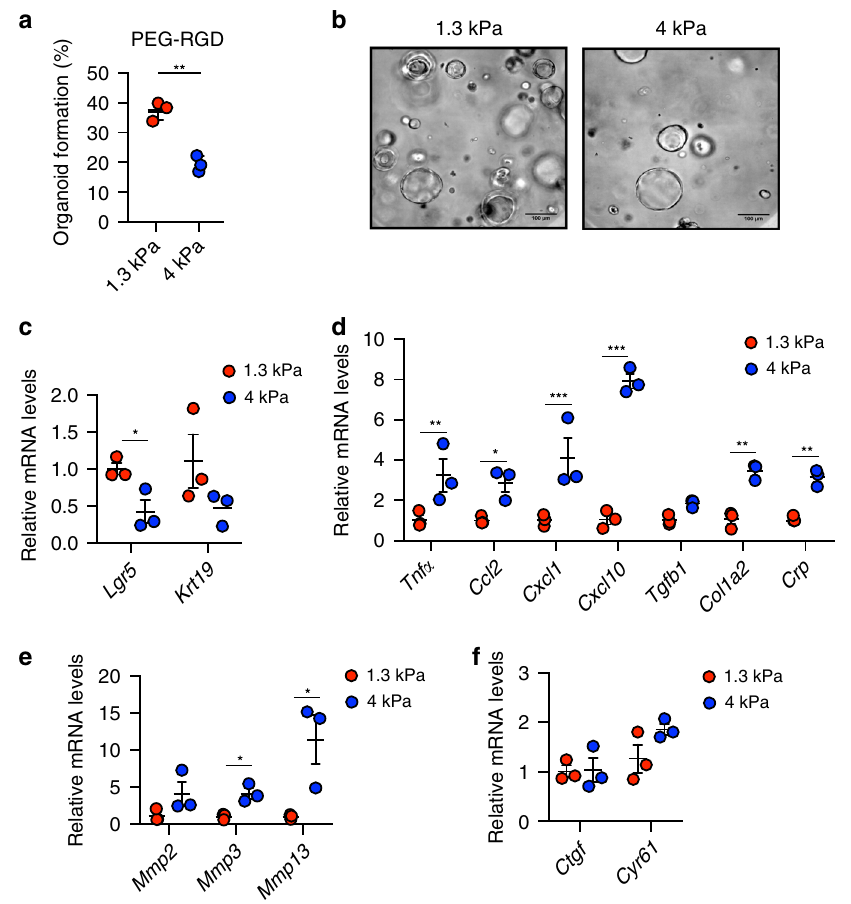
Fig. 4 Hydrogels mimicking the stiffness of native fi brotic liver affect the growth of liver organoids and promote a stress response. a Effect of matrix stiffness on organoid formation ef fi ciency. Graphs show individual data points derived from n = 3 independent experiments and means ± SEM, unpaired Student ’ s two-tailed t -test ( P = 0.0017). b Representative image of organoids 3 days after embedding in PEG-RGD hydrogels of indicated stiffness. Scale bars: 100 μ m. c – f Gene expression was analysed by qRT-PCR in liver organoids 6 days after embedding in PEG-RGD hydrogels with indicated stiffness. Graphs show individual data points derived from n = 3 independent experiments and means ± SEM. c ( P = 0.0218); d ( P = 0.0051; 0.0223; 0.0001; 0.0001; 0.0021; 0.0056); e (0.0127; 0.033). * P < 0.05, ** P < 0.01 *** P < 0.001 unpaired Student ’ s two-tailed t -test ( c , e ) or two-way Anova ( d , f ). Source data are provided as a Source Data fi